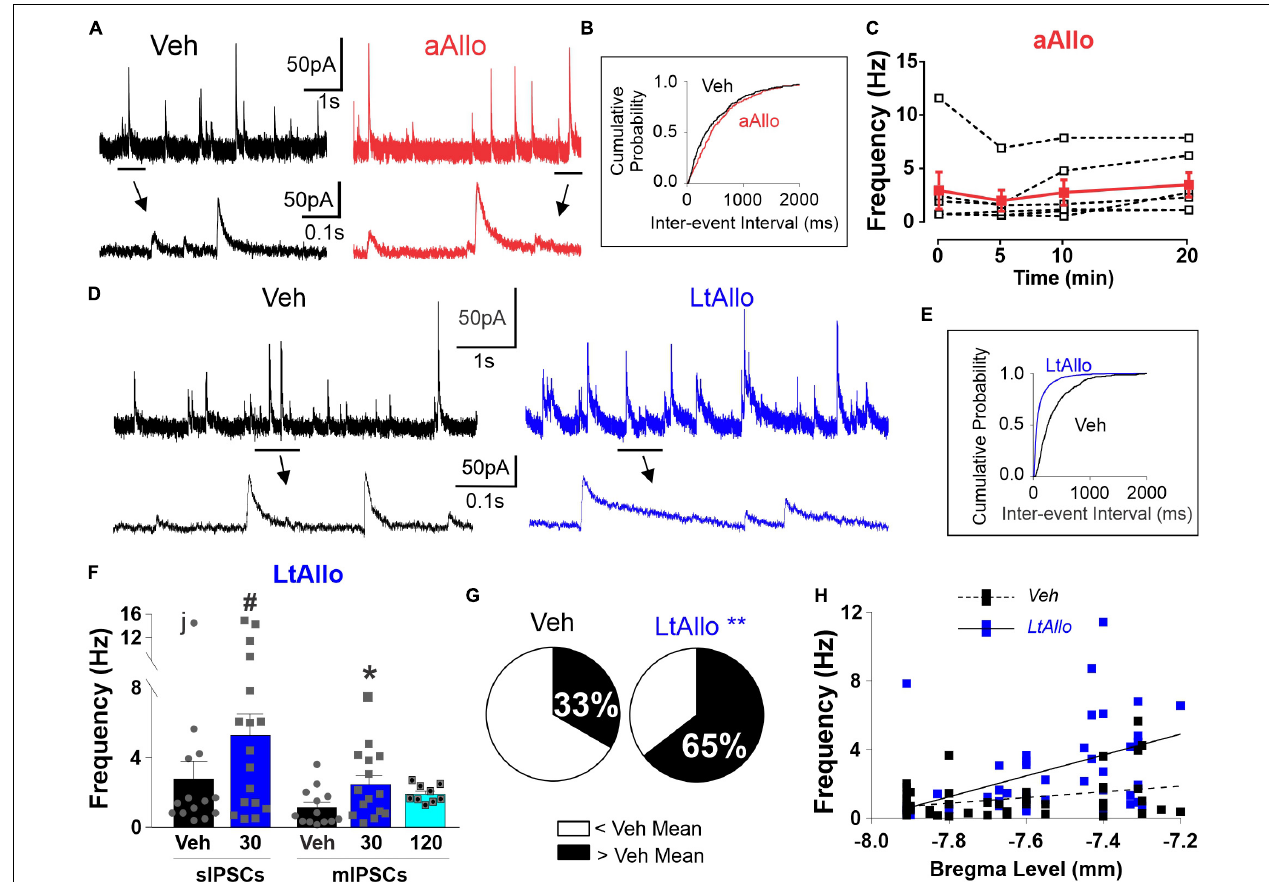
FIGURE 2 | LtAllo in the DMV increases phasic GABA A receptor IPSC frequency. (A) Representative trace of sIPSCs from a DMV neuron during Veh (black) and aAllo (red, 5-min application). Bottom panel: magnified section from top trace as indicated by black line. (B) Representative sIPSC cumulative probability of inter-event-interval during Veh and aAllo treatment in a representative DMV neuron. (C) Mean ± SEM of sIPSCs frequency responses during Veh-application (3.0 ± 1.7 Hz) and aAllo-application at 5- (2.0 ± 1.0 Hz; n = 6 from 3 mice), 10- (2.8 ± 1.2 Hz), and 20-min (3.5 ± 1.1 Hz) in red. Overlaid dashed lines denote individual DMV neuronal responses (black); One-way repeated measure ANOVA. (D) Representative trace of sIPSCs from a DMV neuron during Veh (black trace) and LtAllo (blue trace). Line and arrow indicate section expanded below. (E) Representative sIPSC cumulative probability of inter-event interval (reciprocal of frequency) in a neuron from Veh- and LtAllo treatment. LtAllo left shifts sIPSC cumulative probability. (F) Mean ± SEM of IPSCs frequency in Veh- (black bars) and LtAllo-treated (blue bars) neurons. sIPSCs frequency in Veh- (2.8 ± 1.0 Hz; n = 14 from 10 mice) and LtAllo-treated (5.4 ± 1.2 Hz; n = 17 from 9 mice) neurons. The removal of the neuron labeled with “j” reveals a significantly increased sIPSC frequency after LtAllo. Right-side panel is the mean ± SEM of mIPSC frequency in Veh-treated (1.2 ± 0.3 Hz; n = 13 from 7 mice) and Allo-treated (2.5 ± 0.5 Hz; n = 15 from 9 mice) neurons, indicating that an increased frequency after LtAllo is TTX resistant. This increase did washout by 120 min after Allo incubation (1.9 ± 0.2 Hz; n = 9 from 4 mice). Overlaid points denote individual neuronal responses; j denotes the ROUT identified outlier; unpaired Student’s t -test with Welsh’s correction for sIPSC; Kruskal-Wallis with selected Dunn’s post hoc for mIPSC. (G) Pie graphs illustrating the effect of LtAllo on sIPSC frequency responses expressed as percentage of the total group. Neurons were classified as either greater or less than the mean of Veh-treated frequencies (mean ± SEM of the IPSC frequency of the Veh-treated group). Mann Whitney U test. (H) Correlational analysis of averaged IPSC frequency across bregma level in Veh- (black with dashed line) compared to LtAllo-treated (blue with solid line) neurons recorded for this study (Veh, n = 49; Allo, n = 48). Each square represents a single neuron. # Denotes significant difference from Veh when outlier is excluded, *denotes significant difference from Veh; **denotes significant differences by Mann Whitney U -test. Significance indicates p ≤